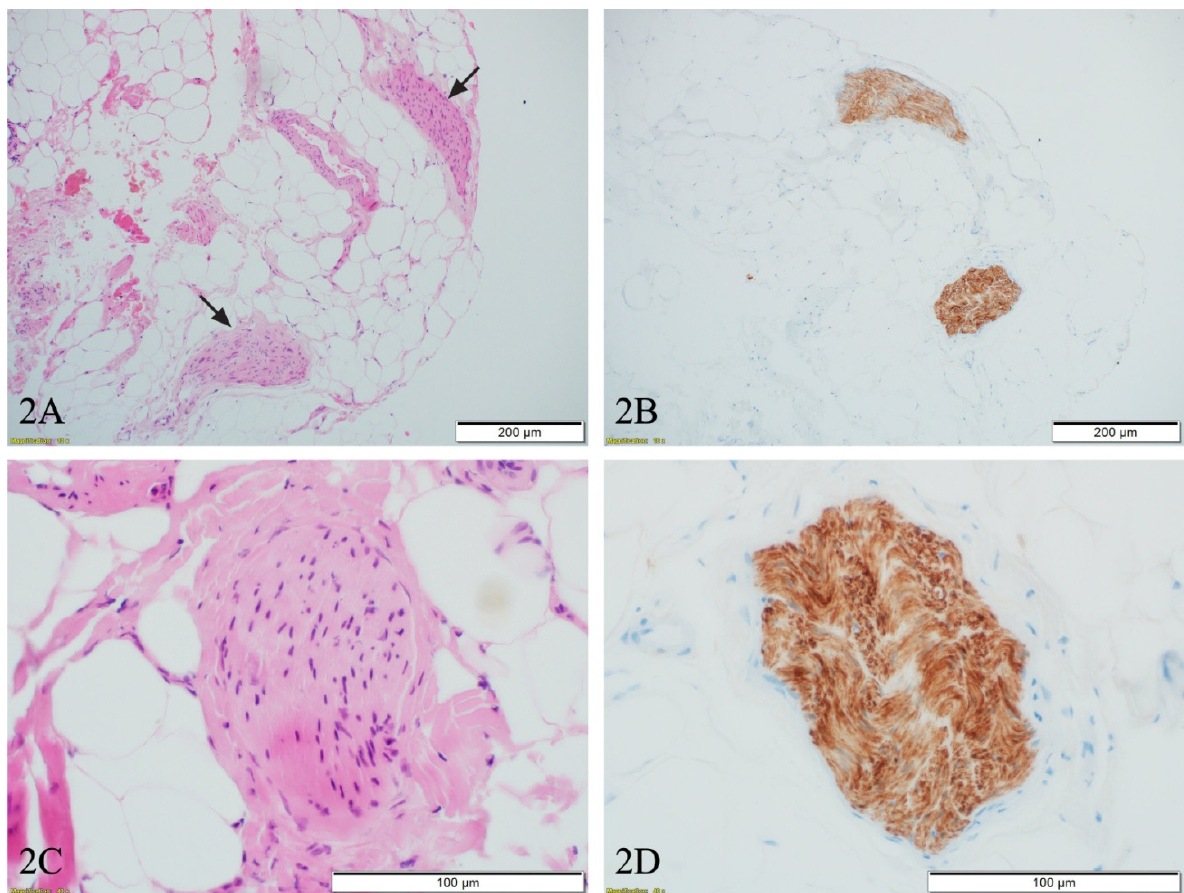
Figure 2. The tissue from laparoscopic biopsy. ( A ): Two nerve fibers (black arrows) surrounded by adipose tissue 1B, H&E, objective × 10; ( B ): Corresponding nerves highlighted with S100 immunohistochemical staining, objective × 10; ( C ): High magnification of nerve fiber, showing no evidence of perineural invasion, H&E, objective × 40; ( D ): Corresponding nerve fiber highlighted with S100 immunohistochemical staining, objective × 40.